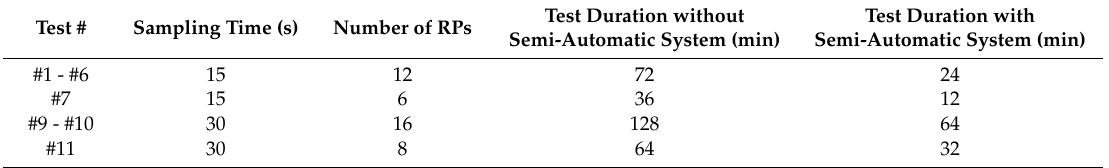
Table 32. Test duration comparison for a semi-automatic and a manual data collection system.